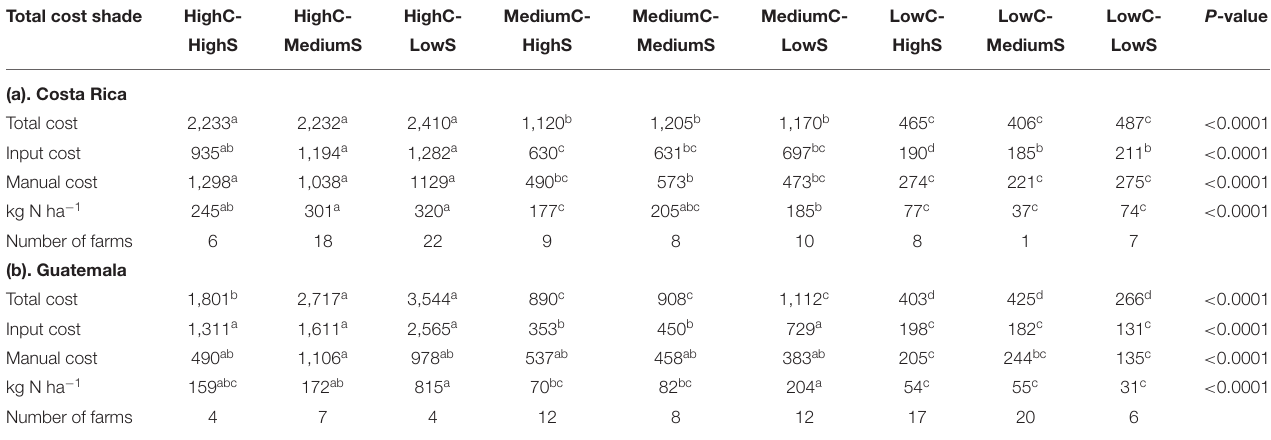
TABLE 6 | Agronomic investment on coffee plantations grouped by high, medium and low total agronomic cost (C) and shade LAI (S) categories. Total cost